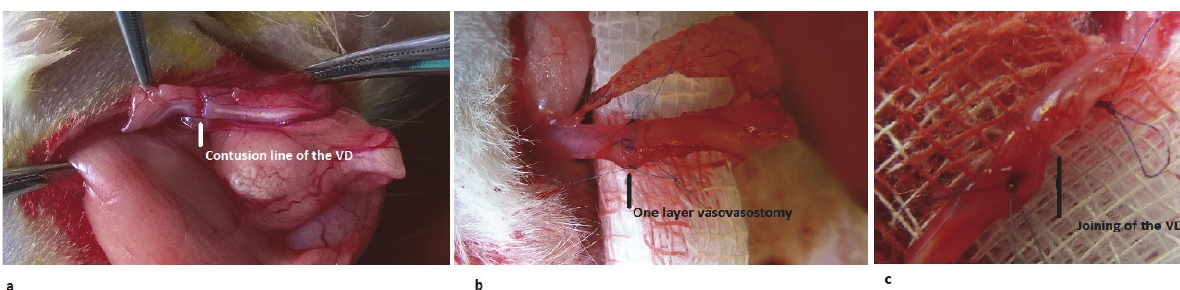
Fig. 1. Photographic schema (magnification: ×14) of the contusion of the vas deferens. (a), operation technique 1 (b), and operation techniques 2 and 3 (c).